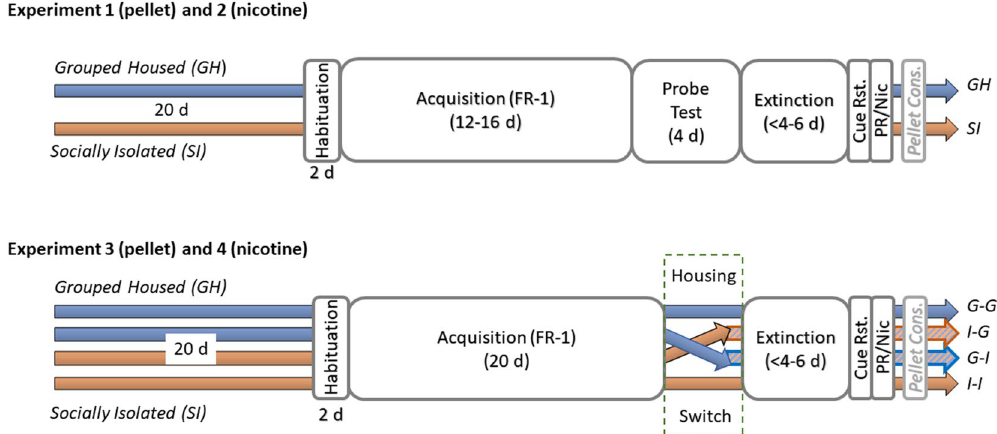
Figure 1. Experimental timeline of the study. Four experiments were conducted separately: experiments 1 and 2 included a probe test (cue only or reward only) and experiments 3 and 4 included a change of housing conditions after acquisition. The number of days spent in each phase of each study are indicated, with cue reinstatement (Cue Rst.), progressive ratio test (for Experiments 1 and 3) and nicotine reinstatement tests (for Experiments 2 and 4) were conducted on single consecutive days. The pellet consumption test (Pellet cons.) was performed for rats in Experiments 1 and 3 only, as these rats received a pellet reward. GH and G–G